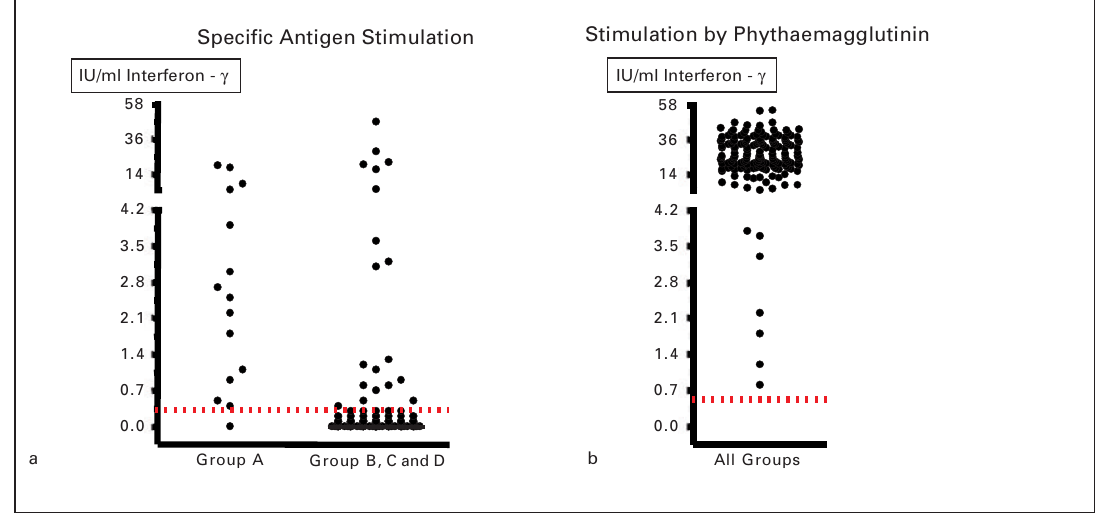
Odds ratio (OR) and 95% confidence inter- vals (Ci) for a positive QTF-GiT in groups with long-term expo- sure (group d, B and A) and a group with short but intense exposure (group C). Those in group d, who should have the lowest risk for acquir- ing lTBi, were con- sidered to be the reference group for calculating the odds ratios.